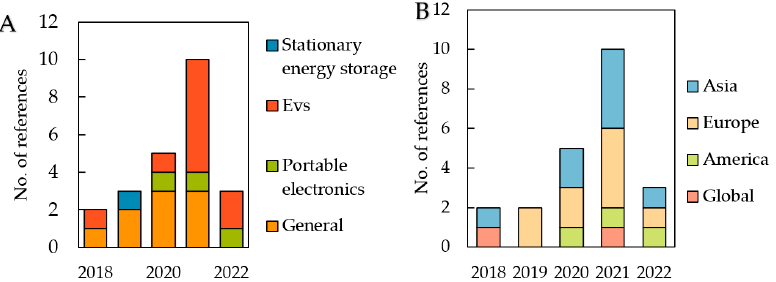
Figure 1. Overview of recent (2018–September 2022) literature studies about material flow analysis for LIBs’ recycling clustered by ( A ) battery applications and ( B ) geographical boundaries.